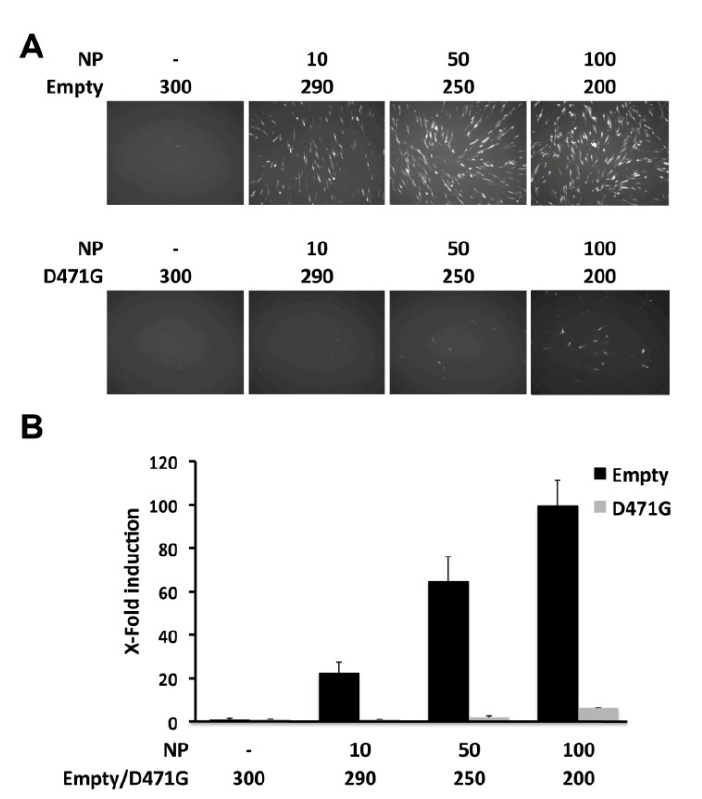
Figure 7. Dominant negative effect of LCMV-NP D471G on viral replication and transcription. BHK-21 cells were co- transfected in triplicate with 0.5 μg of pPolI GFP- Pur/Gluc, 0.6 μg of pC -L, and the indicated amounts (ng) of pC-LCMV-NP HA-tagged (NP); together with empty pC (Empty) or pC LCMV-NP D471G HA- tagged (D471G), and 0.1μg of the pSV40 -Cluc expression vector to normalize transfection efficiencies. At 48 hpt, MG activity was determined by GFP expression (A) and luciferase activity from TCS (B). Reporter gene activation is shown as induction over an empty pC vector- transfected